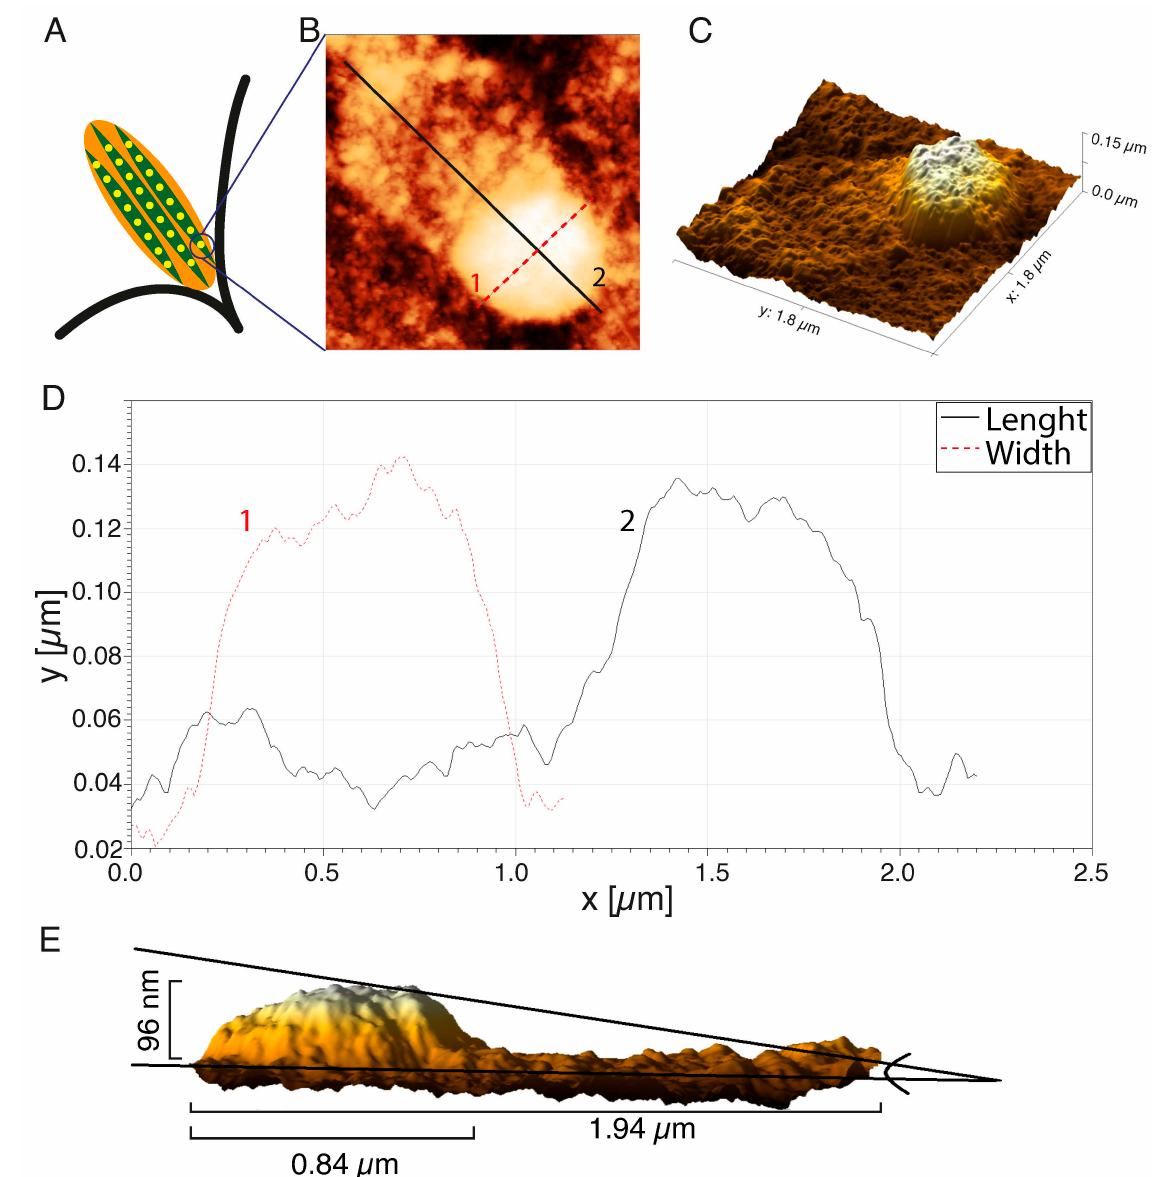
Figure 4. Analysis of topography of the single FA imprints: ( A ) scheme of the FA structure; ( B ) the AFM image of the FA; ( C ) the 3D reconstruction; ( D ) the height distribution of the FA imprints; ( E ) a side view of the FAs reconstruction. AFM images were processed using the Gwyddion 2.53 software.